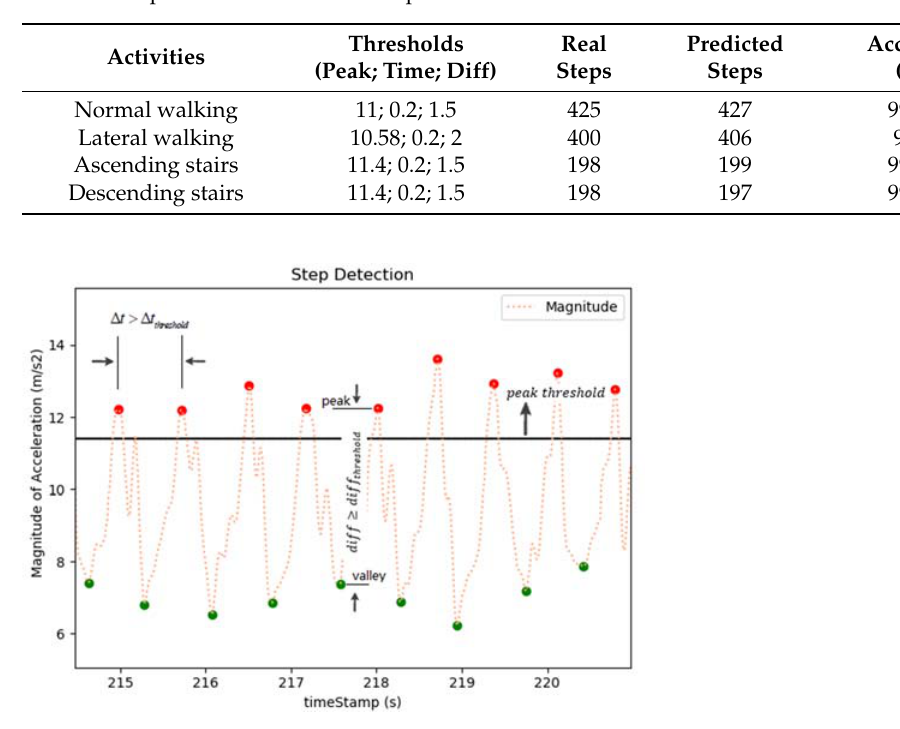
Table 8. The performance details of step detection for different activities.